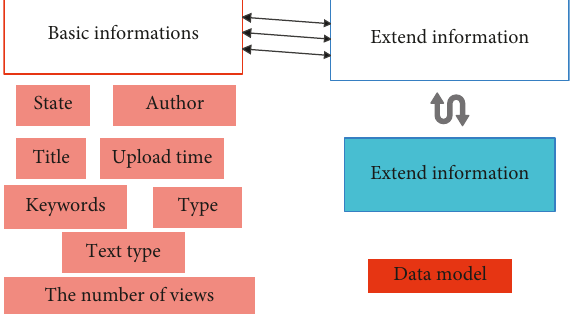
Figure 3: Data structure of online teaching resources of spoken English.